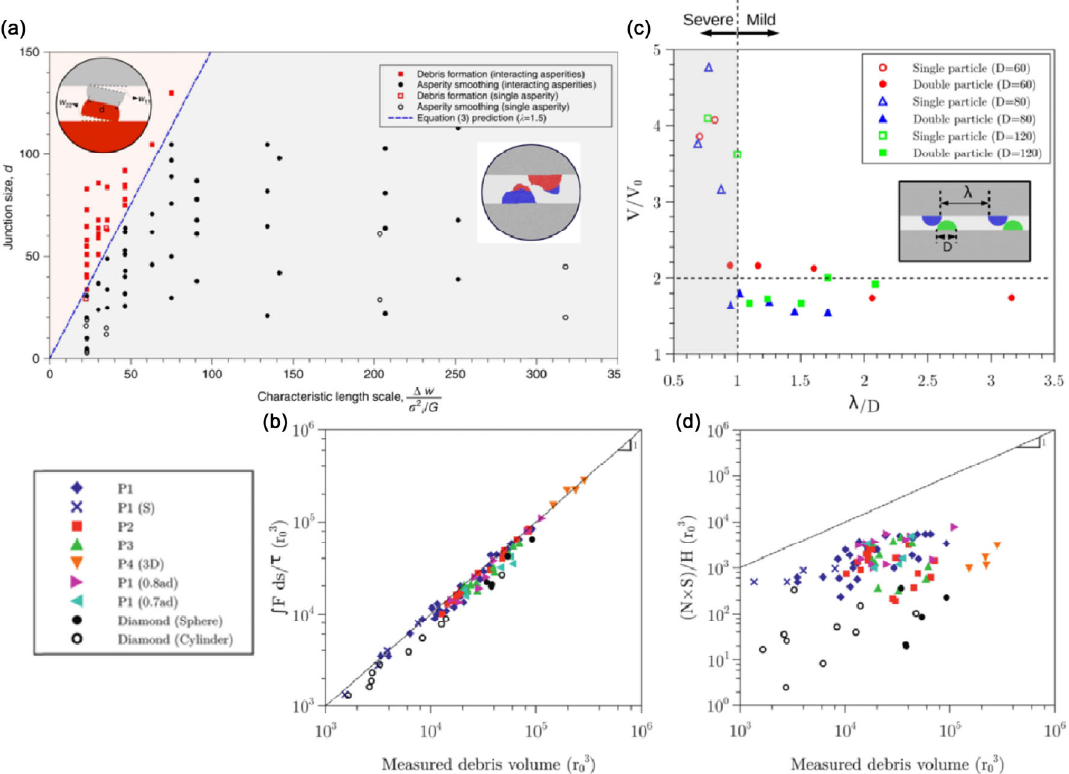
Fig. 31 Summary of atomic simulation results with different asperity size, shape, material hardness, interfacial adhesion, applied load, sliding velocity, and boundary conditions. (a) Characteristic length for debris formation. Reproduced with permission from Ref. [685]. © Springer Nature, 2016. (b) Relation between debris volume and tangential work. Reproduced with permission from Ref. [687]. © Proceedings of the National Academy of Sciences of the United States of America, 2017. (c) A transition of wear condition. Reproduced with permission from Ref. [688]. © American Institute of Physics, 2018. (d) A comparison to Archard’s law. Reproduced with permission from Ref. [687]. © Proceedings of the National Academy of Sciences of the United States of America,